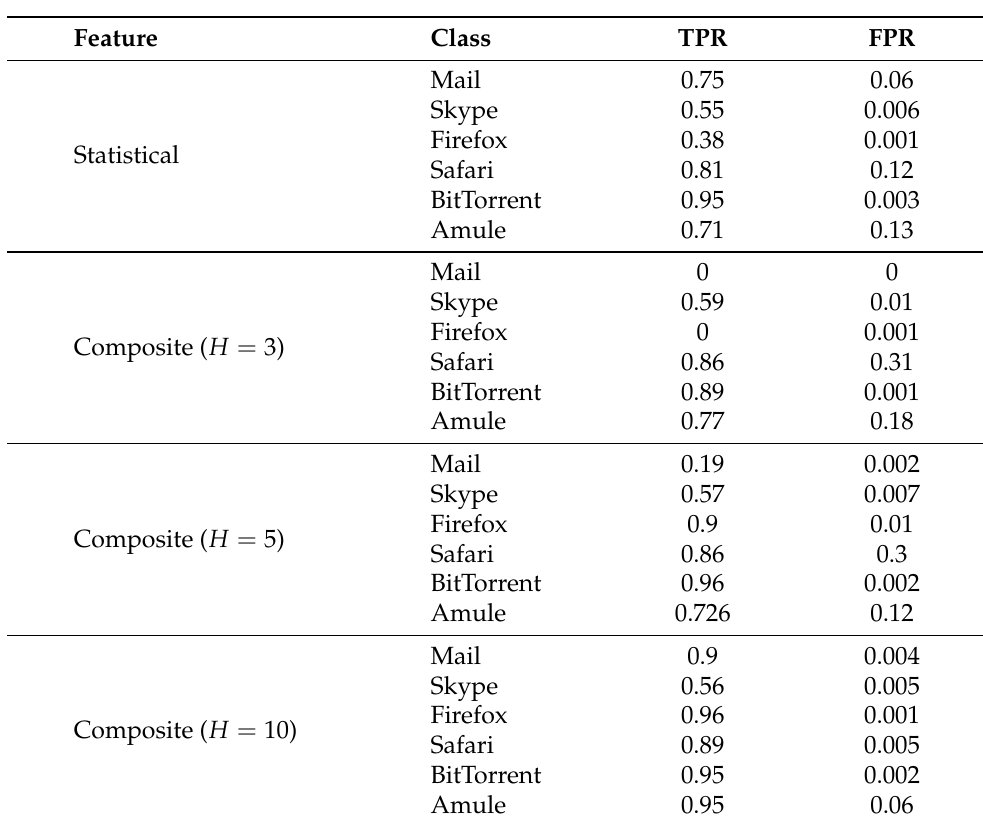
Table 5. SVM: TPR and FPR over UniBS data